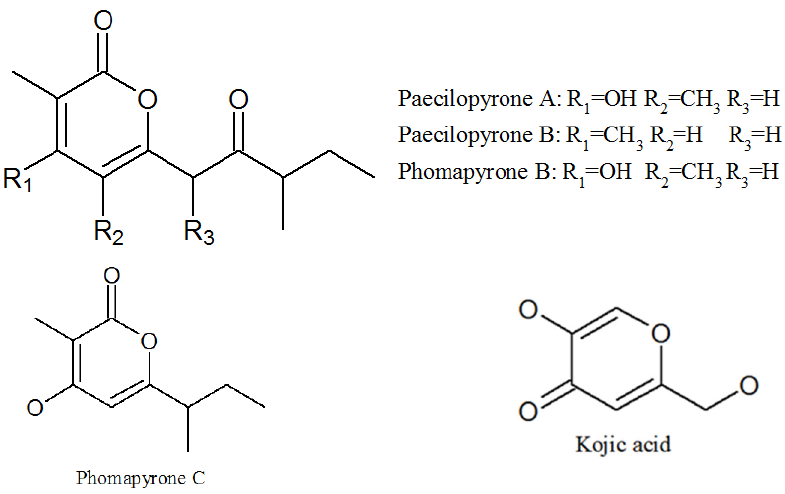
Figure 5. The structures of pyrones.